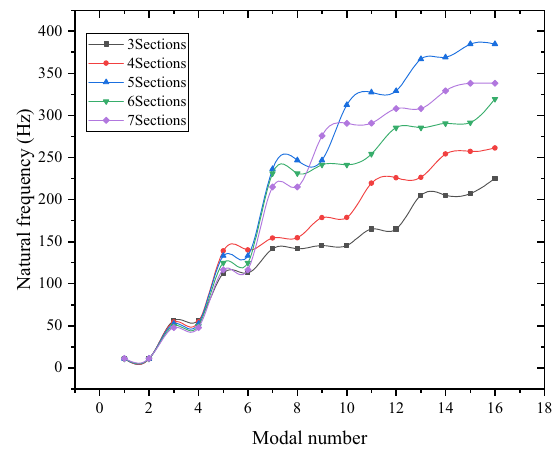
Figure 13 Effect of wall thickness on vibration characteristics